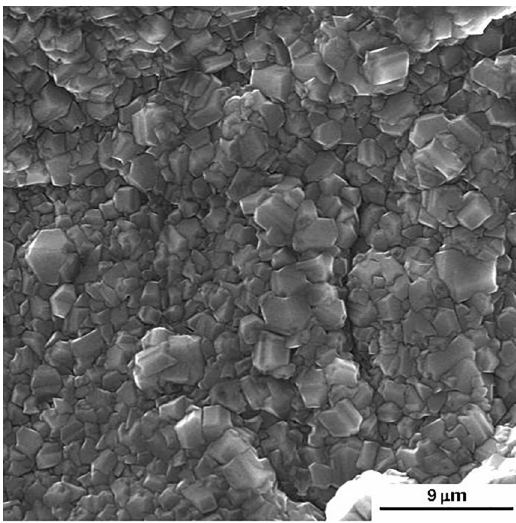
Figure 1. Scanning electron micrograph of diamond film grown on titanium substrate with 15000 ppm B/C.